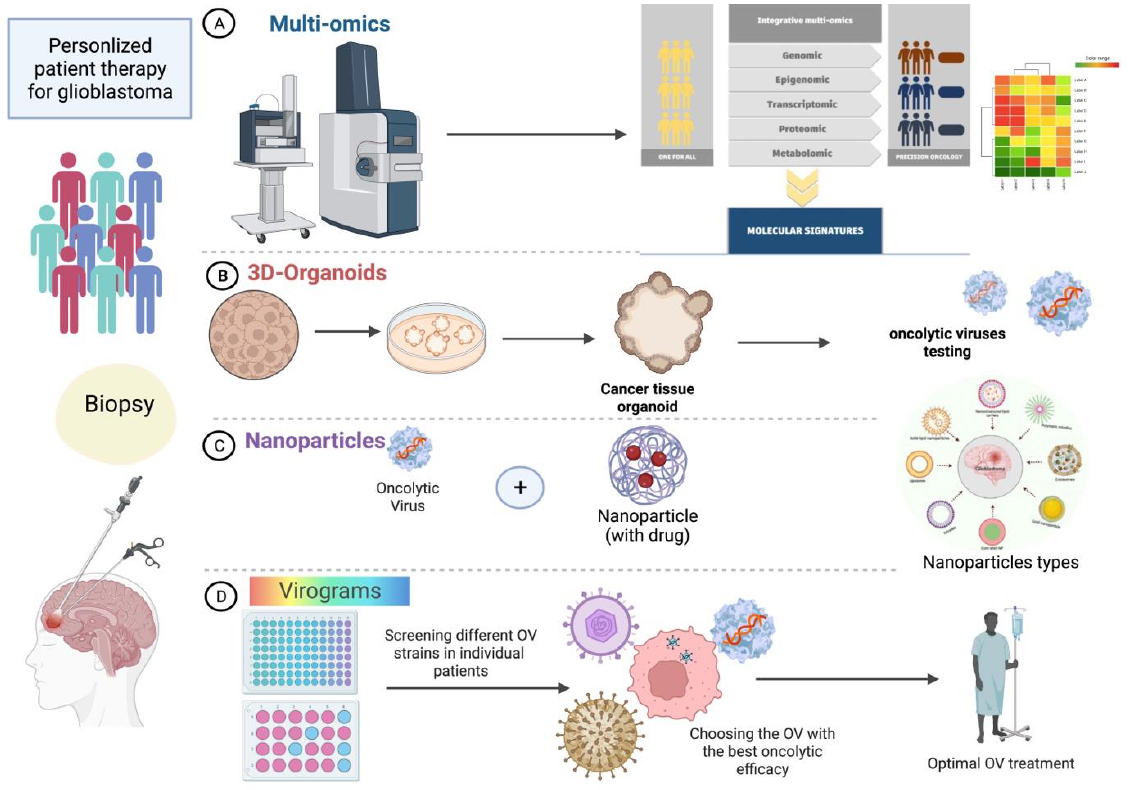
Figure 2. Personalized patient therapy for GB. In perspective trials for GB patients, personalized approaches should be used. Such approaches depend on the individual molecular characteristics of each patient. Analyzing patient biopsies in different platforms allows one to choose the optimal OV by synergizing its effect using new techniques. ( A ) Using multiomics to identify distinct molecular patterns and tumor microenvironment factors to use the optimal OV. ( B ) Using patient tumor cells to make 3D organoids and then testing several OVs on them to choose the appropriate OV for each patient. ( C ) Using nanoparticles to synergize the therapeutic effect of OVs in the patients. ( D ) Using new maps of “Virograms” to screen different OVs in individual patients and use the optimal variant. This leads to the stratification of the patients depending on their molecular patterns. The figure is created with the aid of BioRender.com.